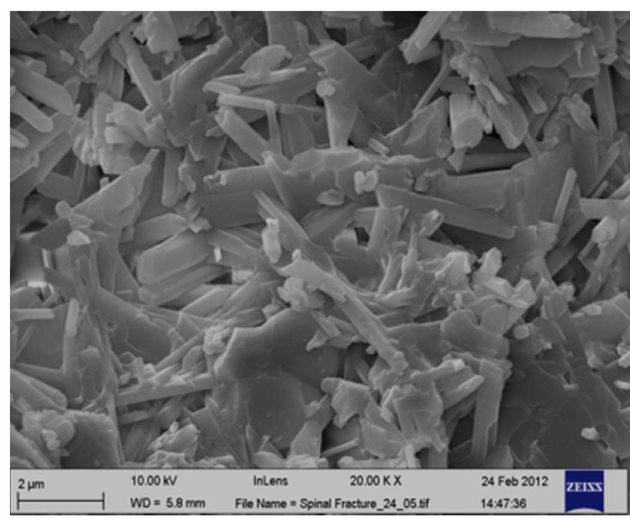
Figure 7. Microradiograph for scanning electron microscopy of calcium sulfate hydrate–hydroxyapatite, which attained compact structures of well-interconnected crystals. The hydroxyapatite crystals are shorter than the calcium sulfate hydrate crystals. Scale bar = 2 µ m.